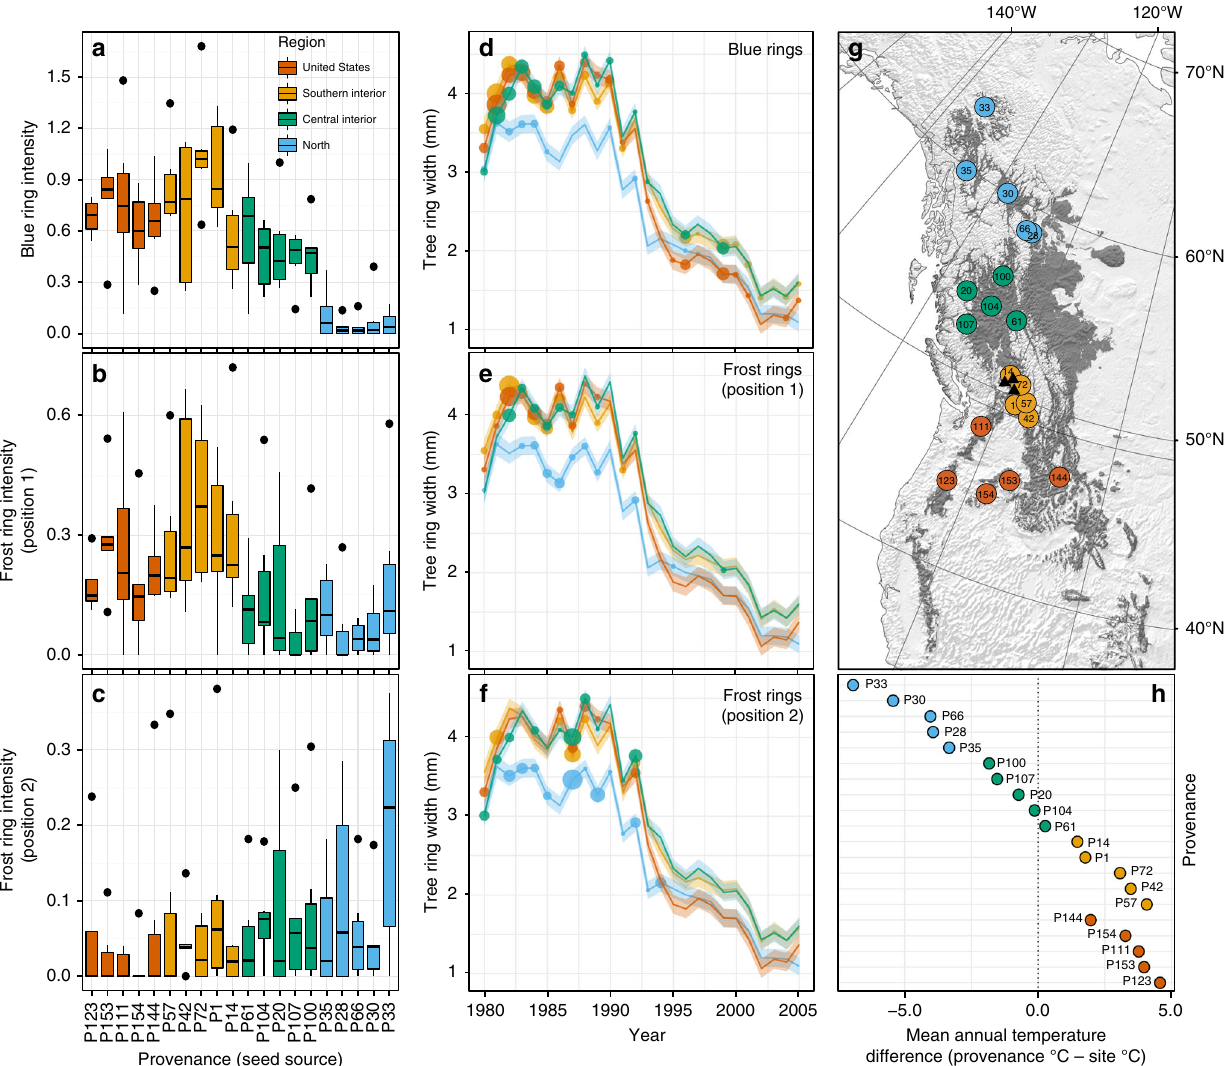
Fig. 2 Blue and frost ring intensities by population and associated annual growth. a – c The distribution and medians of blue ring and frost ring intensities, where provenances are sorted by the mean annual temperature of their source climate (warmest on the left, n = 117). d – f Show how growth is related to blue and frost ring intensities on an annual basis, where average blue and frost ring intensities (including zero values) are represented by the size of the circles. Provenances are colored according to their region and labeled by their identi fi cation number. g The location of provenances and regions as well as the species range of lodgepole pine (dark gray) and the location of test sites sampled in this study (black triangles). The map was produced by the authors with ArcInfo 10.1 using vector and raster data from www.naturalearthdata.com (Public Domain). The species range layer is based on presence/absence raster data created by the authors. h The difference of the provenance source climate to the average climate of the test sites thereby indicates the